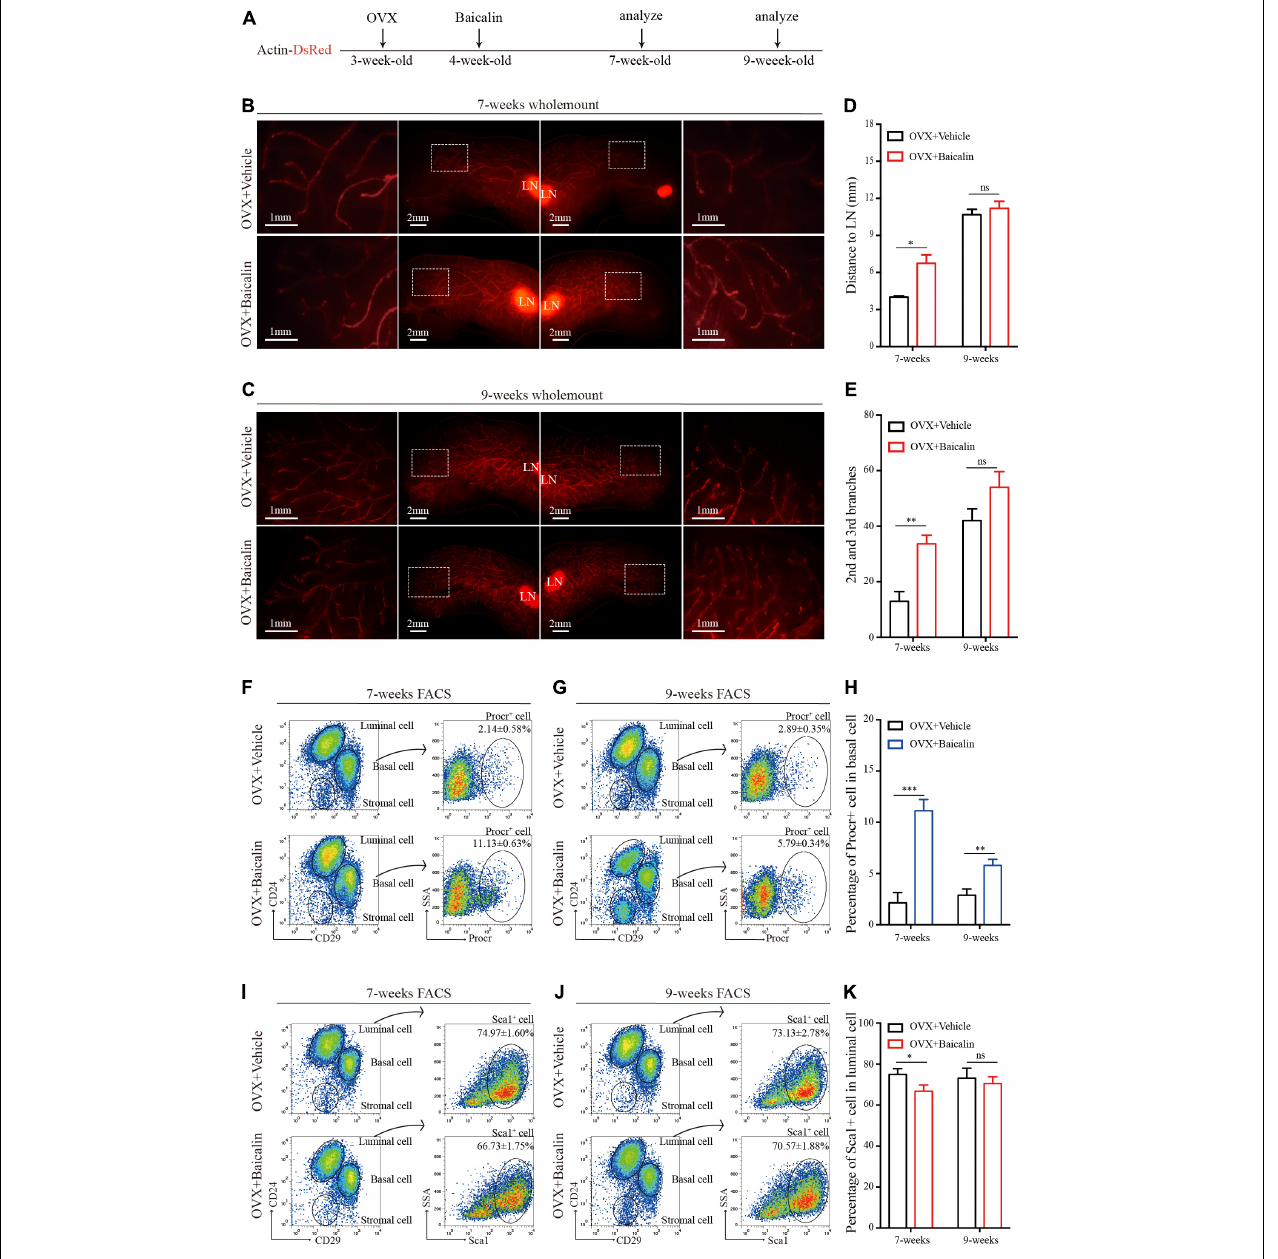
FIGURE 2 | Baicalin accelerates mammary development in an ovariectomized model. (A) Illustration of the baicalin treatment strategy using Actin-DsRed ovariectomized (OVX) mice. Four-week-old OVX mice were treated with baicalin, and mammary glands were harvested from 7- and 9-week-old mice. (B,C) Wholemount staining (red) of mammary glands isolated at from 7-week-old (B) and 9-week-old (C) female mice. The white box indicates the focal structure. The data represent three independent experiments. (D) Quantification of mammary gland duct length indicates that baicalin accelerates the elongation of the mammary gland duct in 7-week-old mice. Student’s t -test: * P < 0.05; ns, not significant. (E) Quantification of lateral branches indicates that baicalin increases the formation of the second and third side branches of mammary glands in 7- but not 9-week-old mice (ns). Student’s t -test: ** P < 0.01; ns, not significant. (F,G) FACS analysis of mammary epithelial cells revealed the percentages of Procr + basal cells in 7-week-old (F) and 9-week-old (G) mice. (H) Quantification analysis indicates that baicalin increases the number of Procr + basal cells in 7- and 9-week-old mice. Student’s t -test: *** P < 0.001; ** P < 0.01. (I,J) FACS analysis of mammary epithelial cells revealed the percentages of Sca1 + luminal cells in 7-week-old (I) and 9-week-old (J) mice. (K) Quantification analysis indicates that baicalin decreases the number of Sca1 + luminal cells in 7-week-old mice. Student’s t -test: * P < 0.05; ns, not significant.